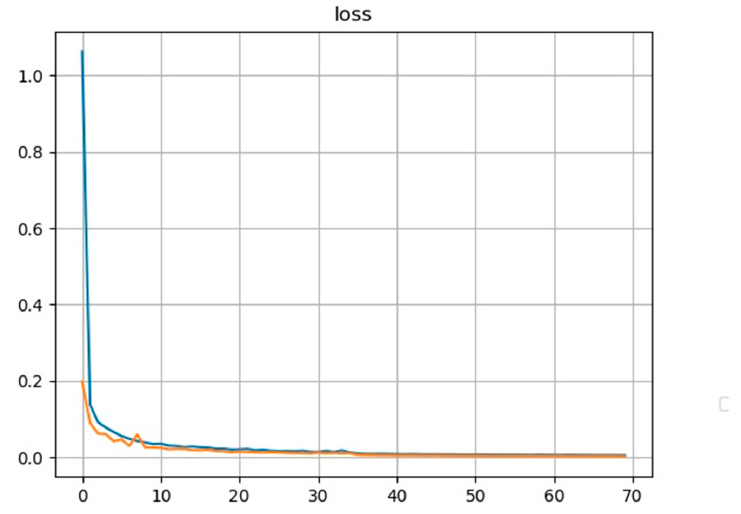
Figure 9. Model loss and accuracy curves as functions of iterations.